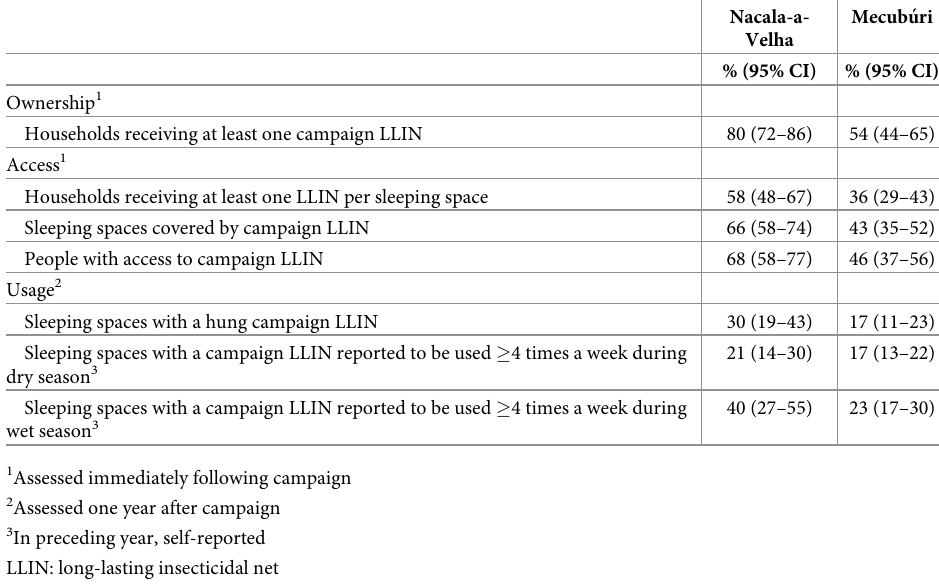
Table 2. Coverage with LLINs immediately following a mass LLIN distribution campaign in 2013 in Nacala-a- Velha and Mecubu´ri Districts, Mozambique.